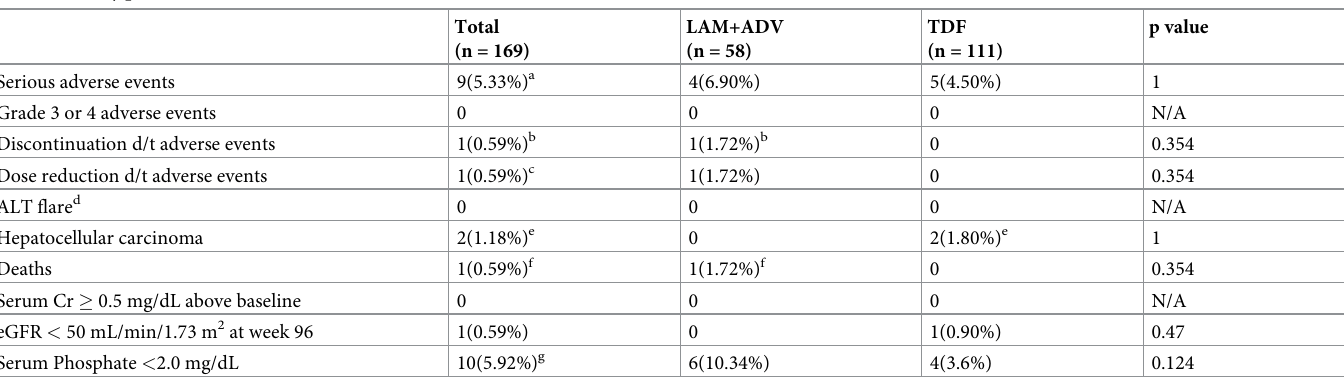
Table 5. Safety profiles at 96